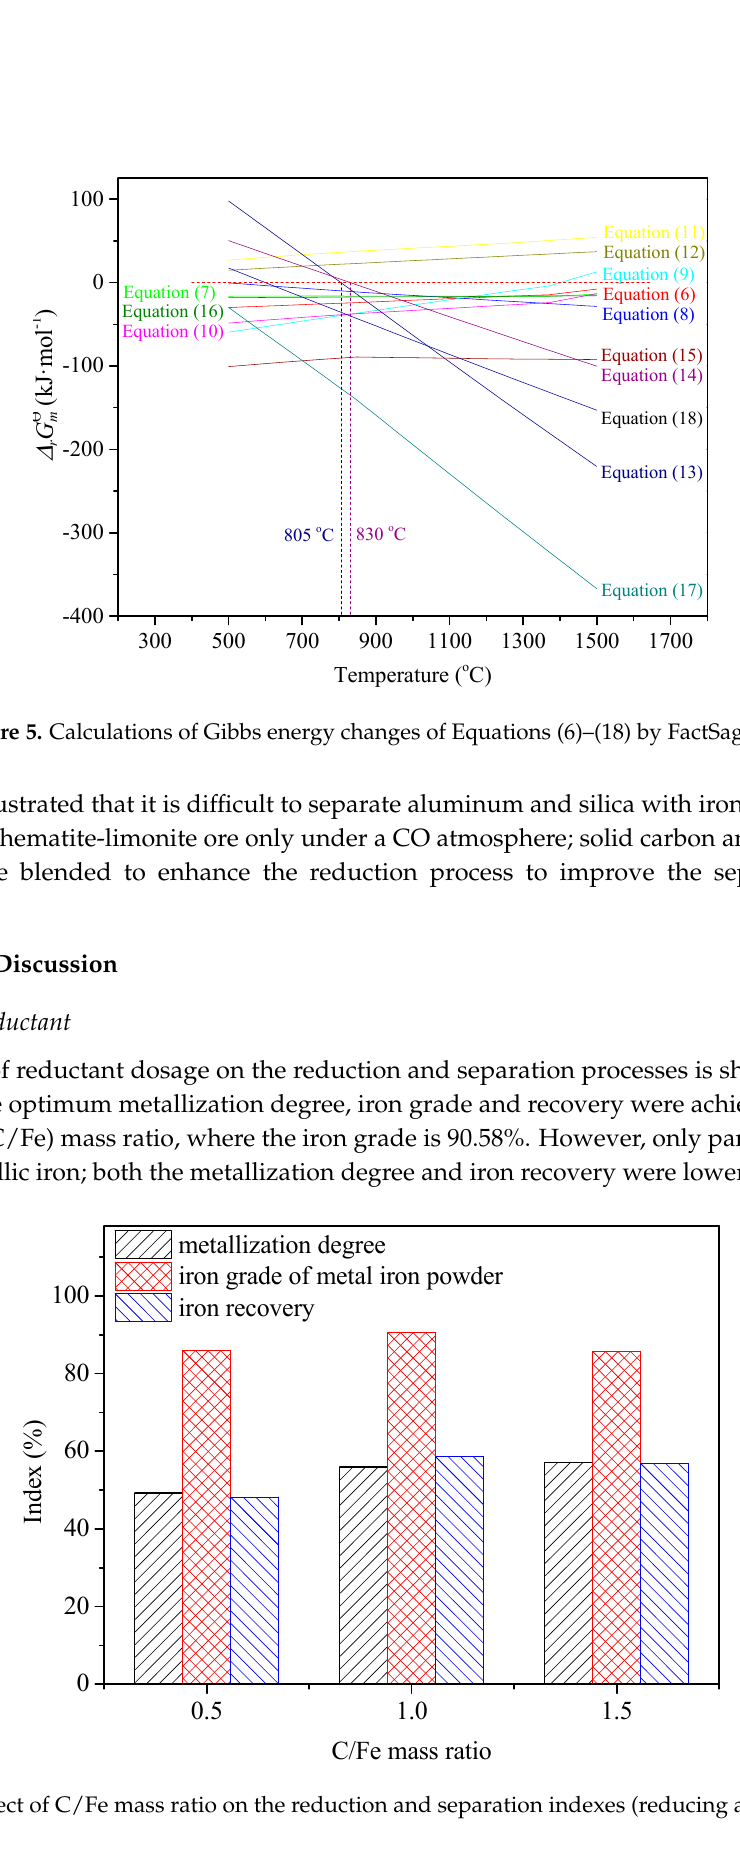
Figure 6. Effect of C/Fe mass ratio on the reduction and separation indexes (reducing at 1300 °C for 20 min).